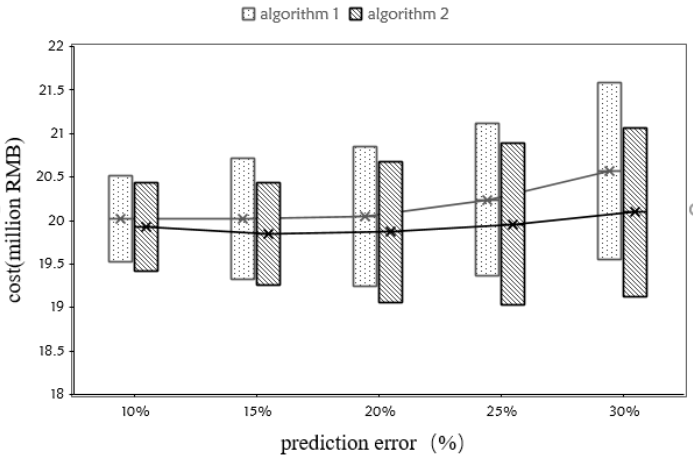
Figure 5. Optimal cost intervals in Algorithm 1 and Algorithm 2.